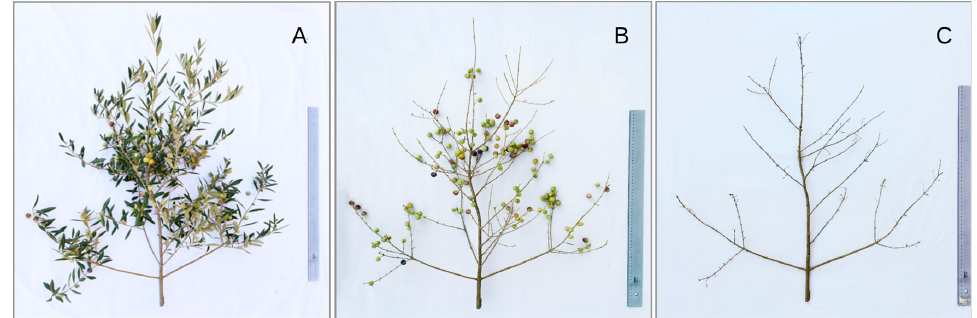
Figure 1. Example of a two-year-old bearing branch with leaves and fruits ( A ), defoliated ( B ), and bare frame (C) from ‘Arbequina’ olive trees.